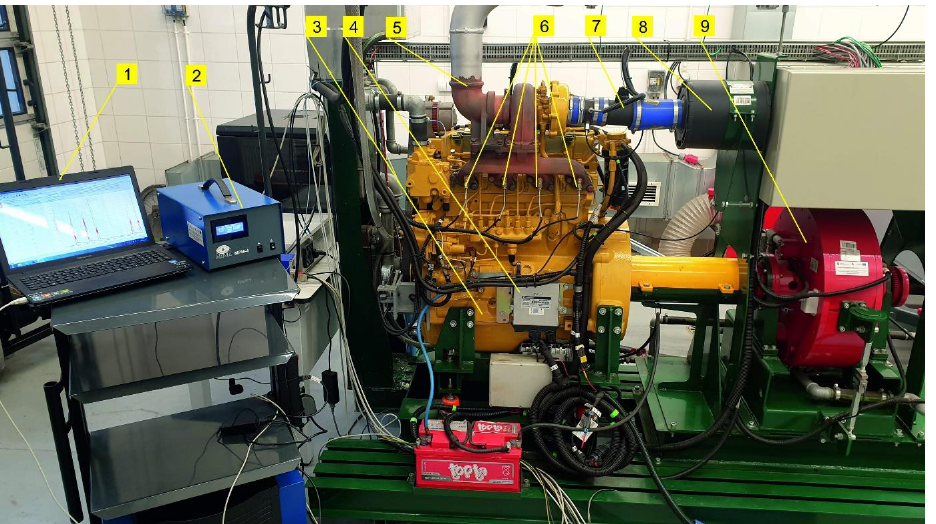
Figure 3. Engine dynamometer test stand: 1 — PC-data recorder, 2 — MPM4, 3 — John Deere engine, 4 — engine management unit, 5 — exhaust fumes outport, 6 — fumes temperature probes, 7 — air flow meter, 8 — air inlet filter, 9 — eddy current engine brake.